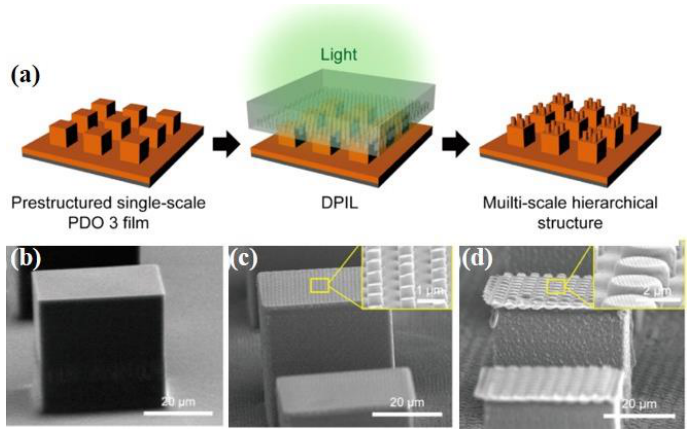
Figure 8. Hierarchical micro–nanostructures formed by DPIL: ( a ) Schematic illustration of the fabrication process, ( b ) cross-sectional SEM images of a prestructured box pattern; ( c ) dual-scale structure with a submicron pillar pattern on top, and ( d ) the triple-scale structure with a sub-100 nm line pattern on top and a micron-pillar patterns on the second level. (Reproduced from [95] with permission; Copyright 2017 American Chemical Society).